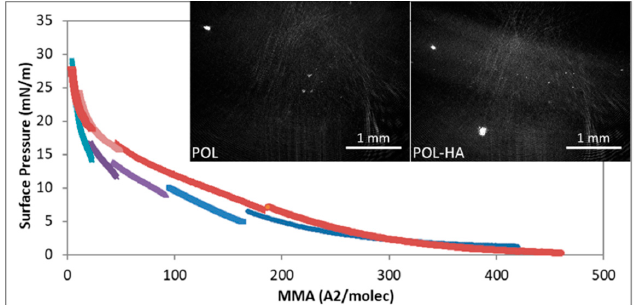
Figure 6. Surface pressure ( π )-mean molecular area (MMA) isotherm of POL monolayers in pure water subphase (blue and purple) and in HA 3 × 10 − 3 (g / L) subphase (red and pink). MicroBAM images of POL and POL + HA at π = (12 ± 1) mN/m.